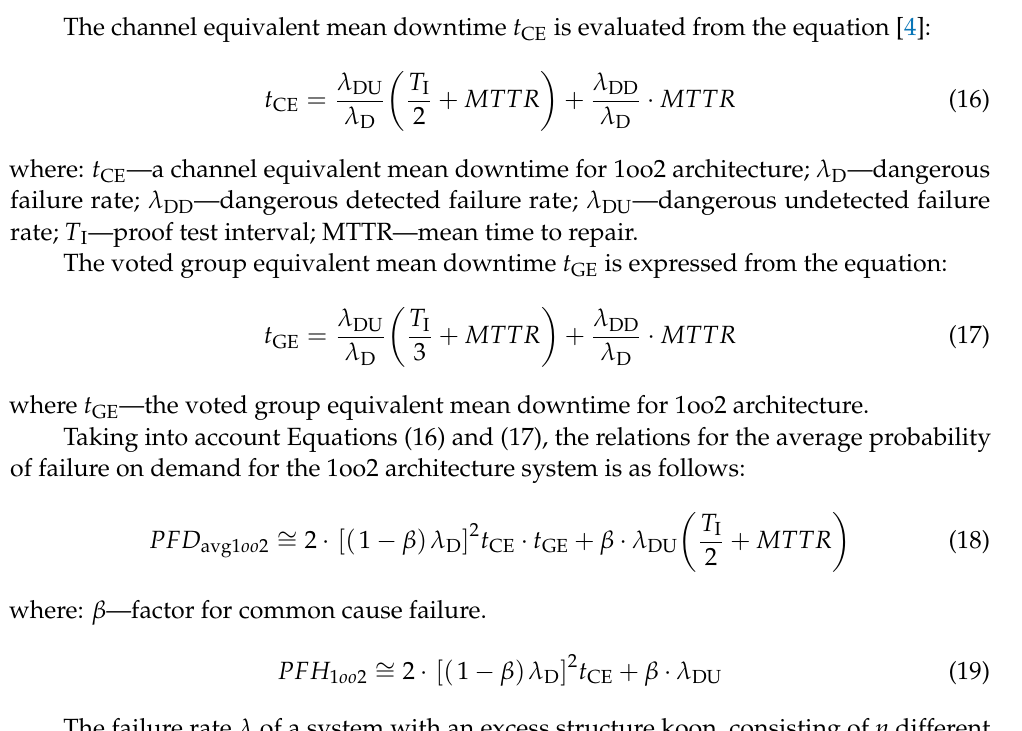
Figure 15. Reliability block diagram for 1oo2 E/E/PE